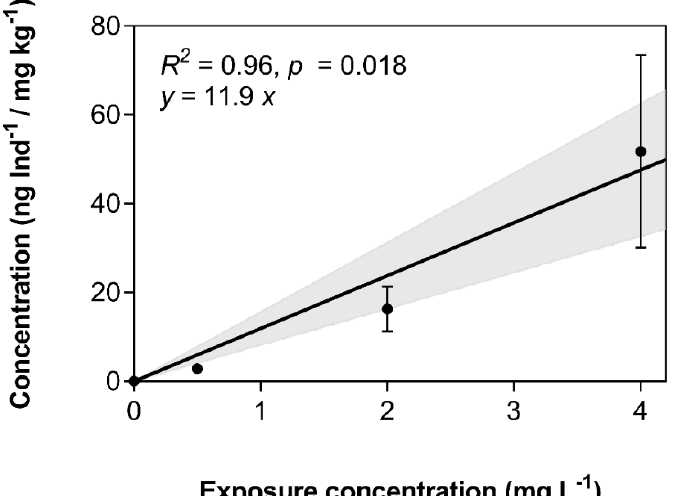
Figure 4. Linearity of bioconcentration of 3,4-dichloroaniline (3,4-DCA) depending on exposure concentration. Data represent the average ± standard deviation of the 3,4-DCA concentration in all surviving larvae after 120 hpf of n = 2 independent experiments. The regression equation, as well as Pearson’s correlation metrics, are provided. The shaded area indicates the 95% confidence interval of the regression line. Larvae of zebrafish 120 hpf weighed 1.0 mg wet weight; in consequence, concentrations on the y-axis translate directly to mg kg −1 .